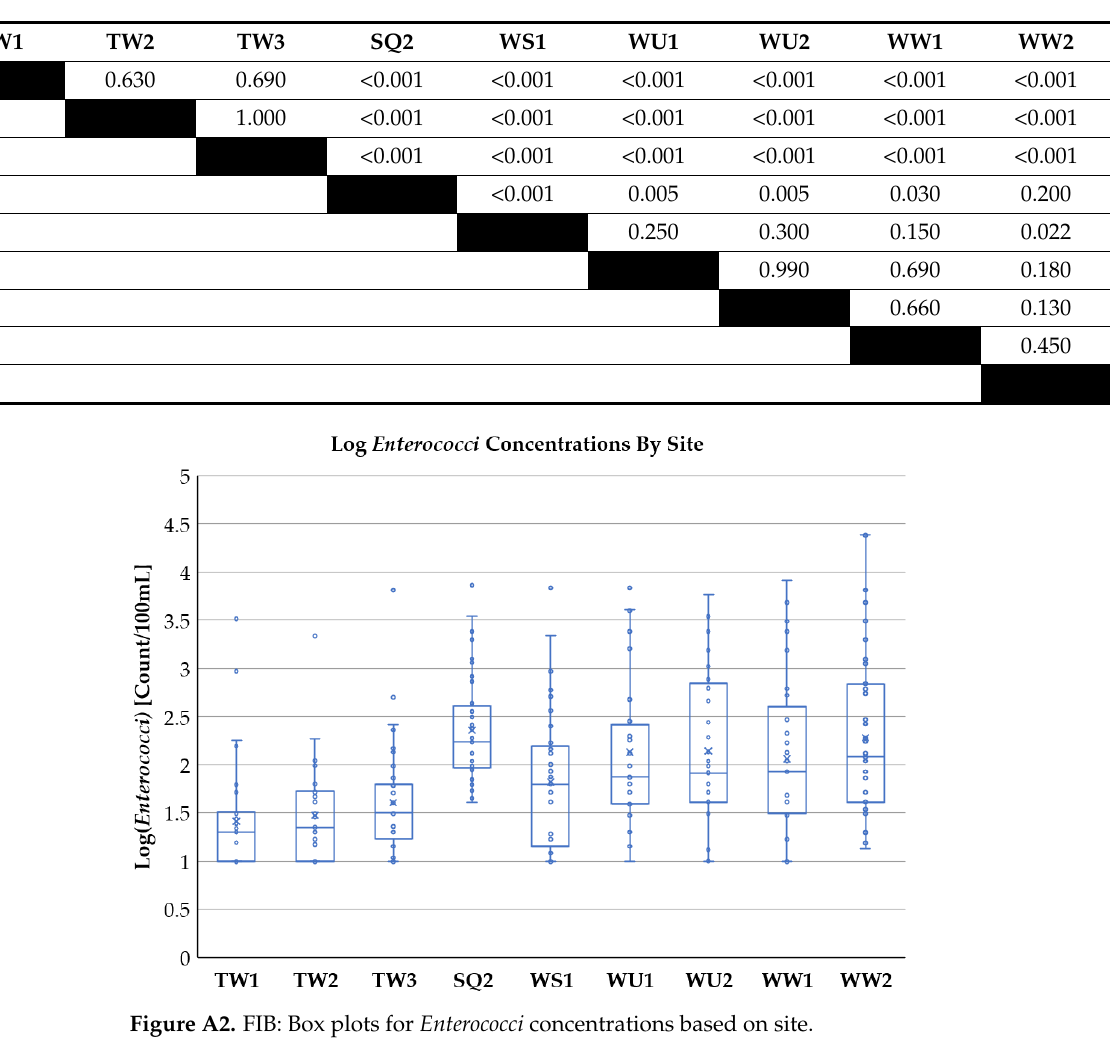
Table A5. Wilcoxon sum test p -values, E. coli .